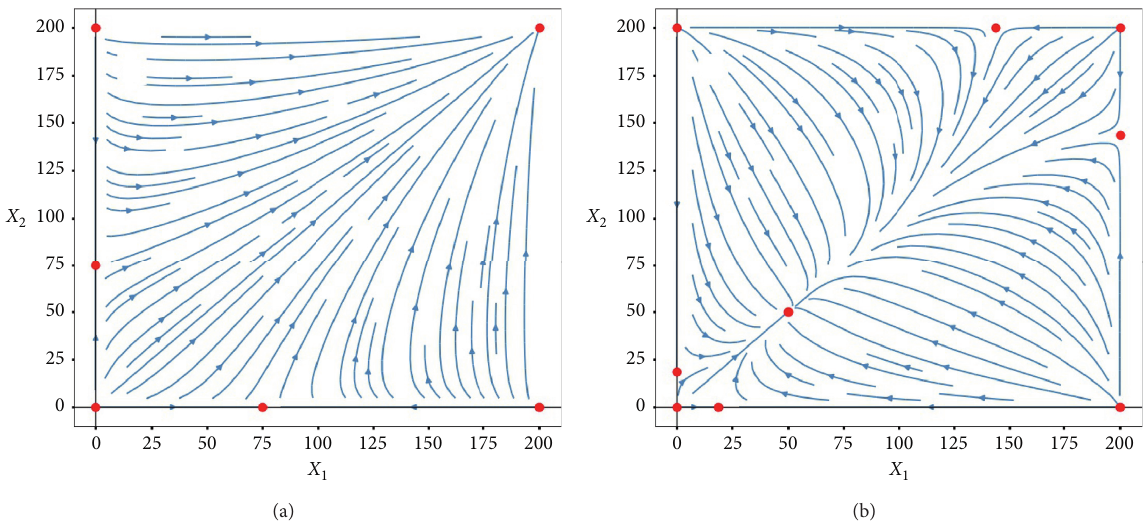
Figure 11: Facultative-facultative mutualism with negative intraspecific interaction: (a) we have the case where b means that intraspecific competition is weaker than mutualism; (b) we have b is stronger than mutualism. Here, r